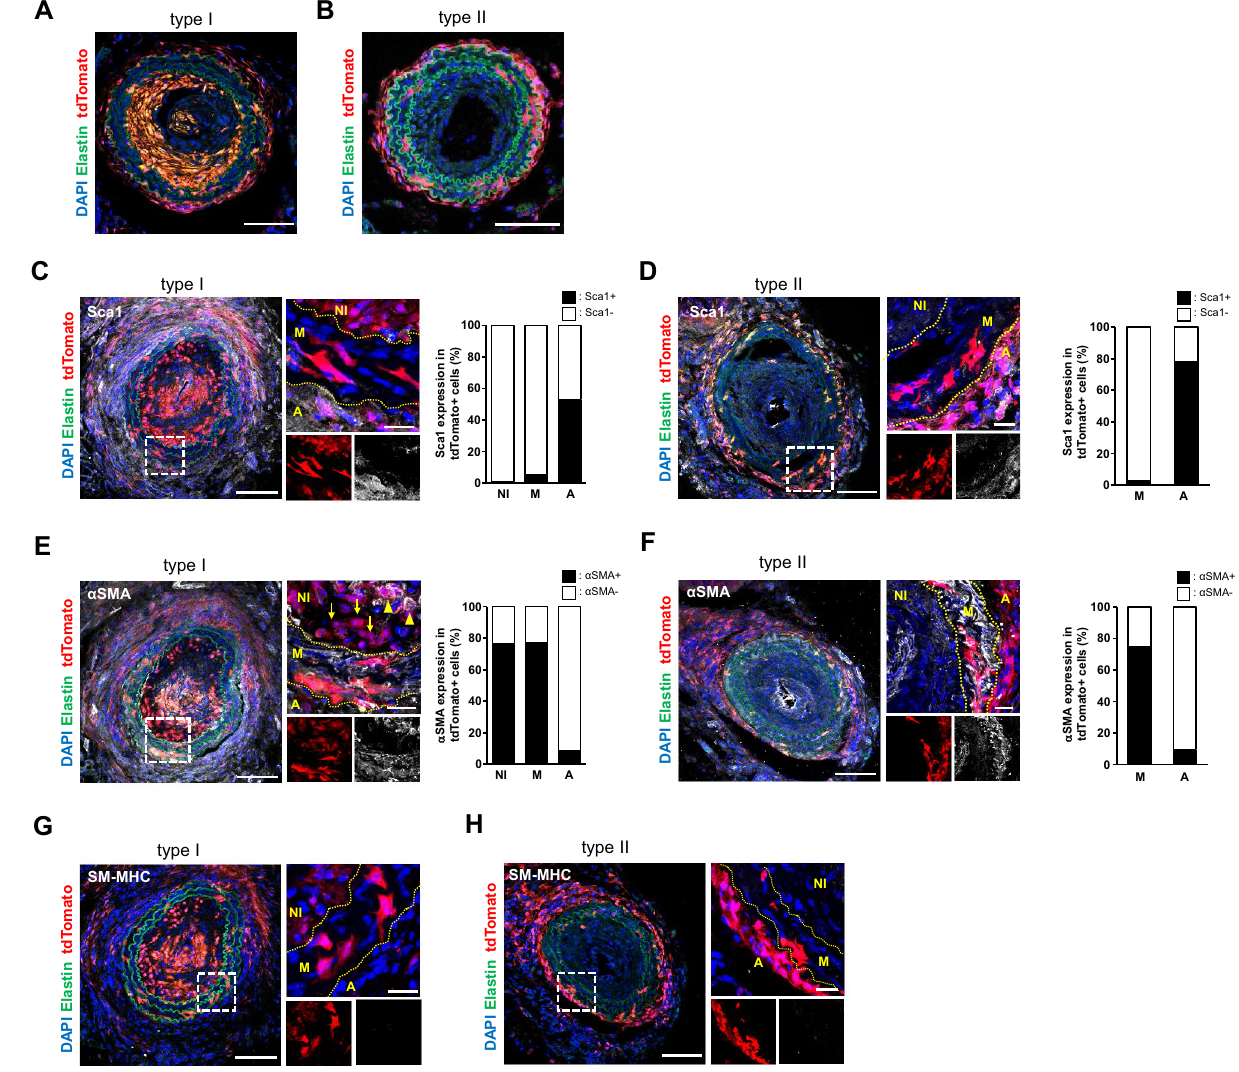
Figure 4. Two types of neointima formed by distinct SMCs after carotid artery ligation. ( A , B ) Representative images of type I ( A ) and type II ( B ) neointima at 56 days after ligation. Scale bars: 100 µm. ( C , D ) Immunostaining for Sca1 on carotid artery sections from type I ( C ) and type II ( D ) neointima. The dotted boxed area is shown on the right with higher magnification. Quantification of the percentage of Sca1 expressing cells in tdTomato+ cells within the vessel wall. Data are presented as the mean ± SEM, N = 3–8 per group. NI: neointima, M: media, A: adventitia. Scale bars: 50 µm. Scale bars in insets: 20 µm. ( E , F ) Immunostaining for αSMA on carotid artery sections from type I ( E ) and type II ( F ) neointima. Arrowheads indicate tdTomato+/ αSMA+ cells in the neointima. Arrows indicate tdTomato+/αSMA- cells. The dotted box area is shown on the right present an image with higher magnification. Quantification of the percentage of αSMA-expressing cells in tdTomato+ cells within the vessel wall. Data are presented as the mean ± SEM, N = 3–8 per group. NI: neointima, M: media, A: adventitia. Scale bars: 100 µm, Scale bars in insets: 20 µm. ( G , H ) Immunostaining for SM-MHC on carotid artery sections from type I ( G ) and type II ( H ) neointima. The dotted box area is shown on the right with higher magnification. NI: neointima, M: media, A: adventitia. Scale bars: 100 µm, box, Scale bars in insets: 20